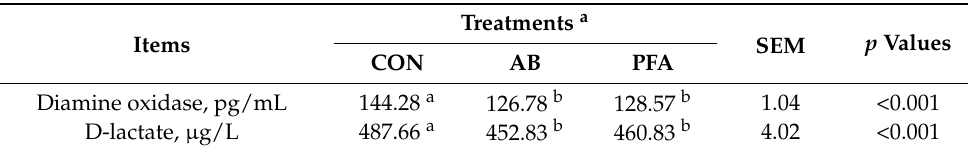
Values are presented as mean and standard error of mean (SEM). a,b Means with different superscripts within a